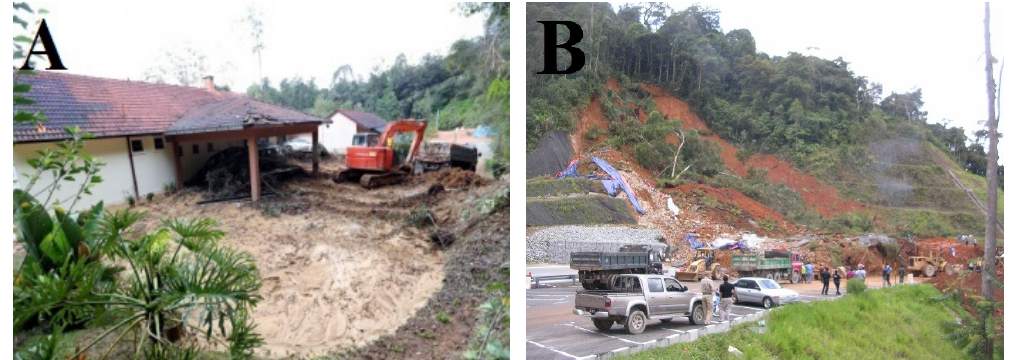
Figure 14. Field photographs showing landslide locations during field investigation in ( A ) Tanah Rata and ( B ) Tanah Runtuh.